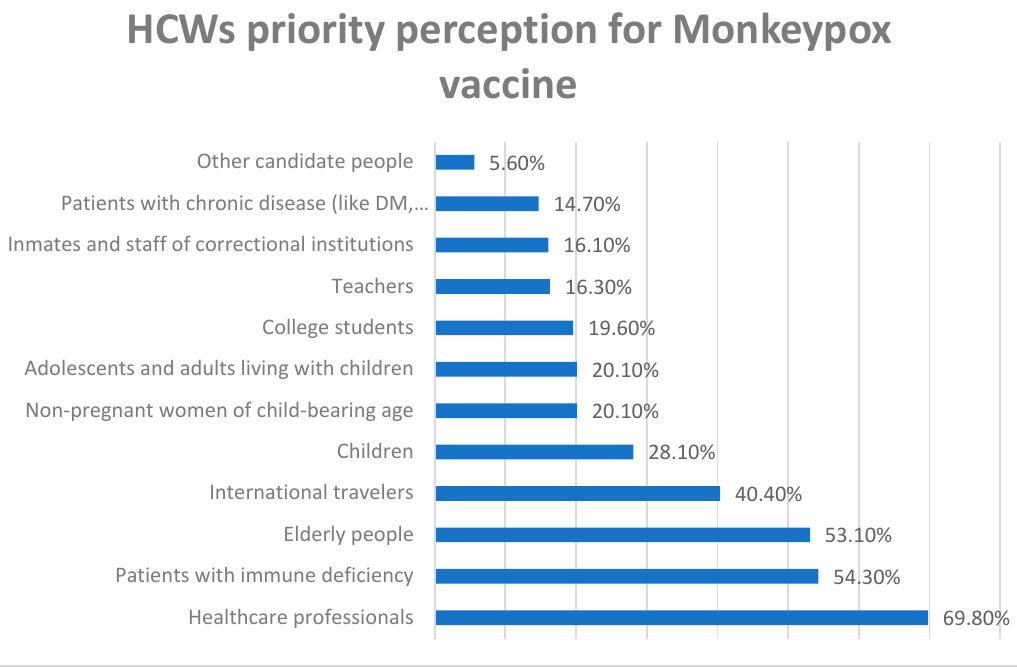
Figure 1. HCWs’ priority perception for Monkeypox vaccine. Table 4. Multivariate binary logistic regression analysis of the HCW’s odds of high worry from Monkeypox compared to COVID-19.